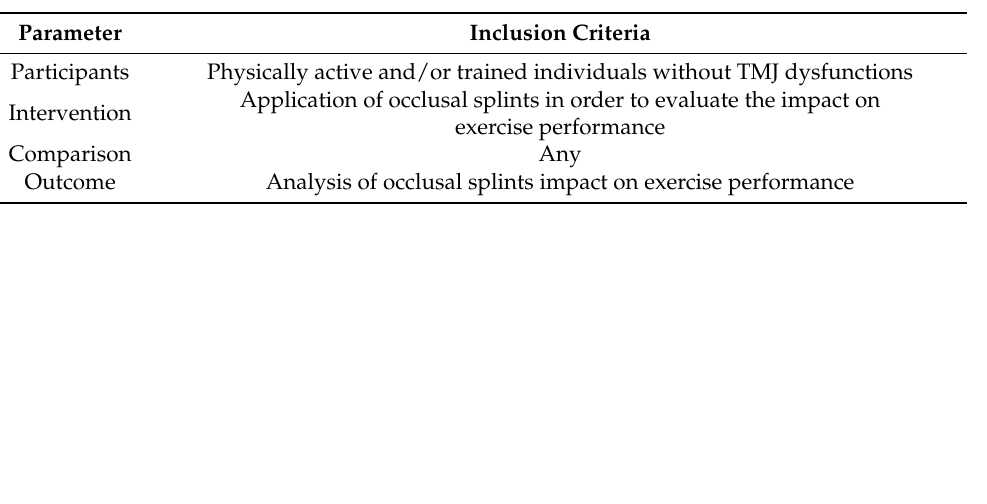
Table 1. Summary of the inclusion criteria following the PICO